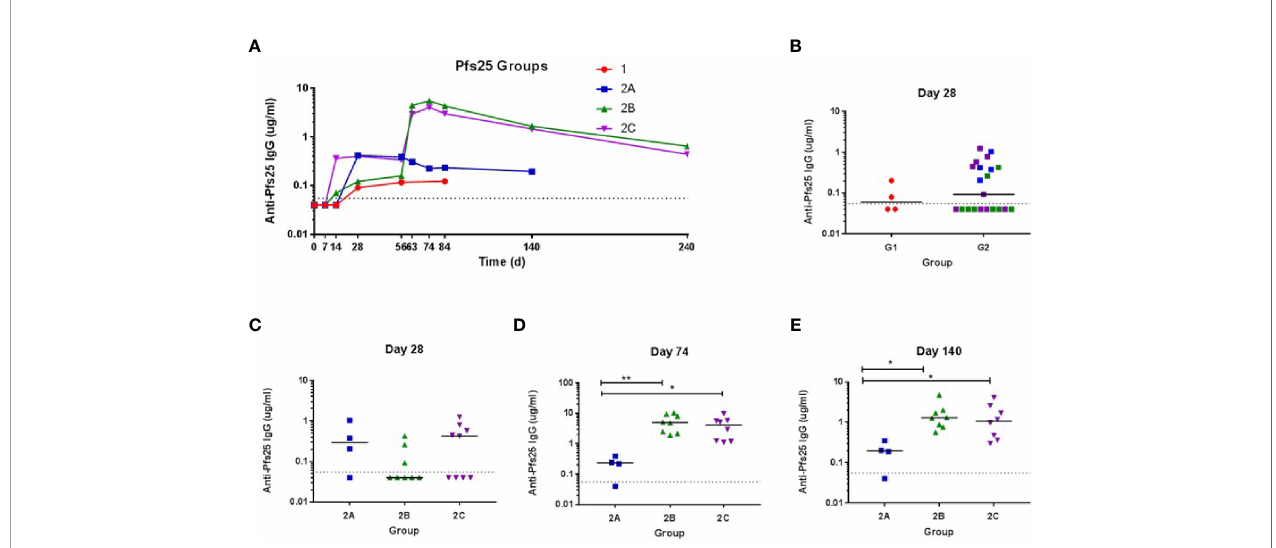
FIGURE 4 | Serum antibody response against Pfs25. (A) Median anti – Pfs25 serum total IgG responses shown for all groups over time. Median and individual responses are shown at (B, C) day 28, (D) day 74, and (E) day 140. The horizontal dotted line indicates the limit of detection of the assay. Symbols are coded according to group. *P < 0.05, **P < 0.01. Responses between Groups 1 and 2 were assessed by Mann-Whitney test (B) . Responses in groups 2A (n = 4), 2B (n = 8), and 2C (n = 8) were assessed by Kruskal-Wallis test with Dunn ’ s multiple comparison